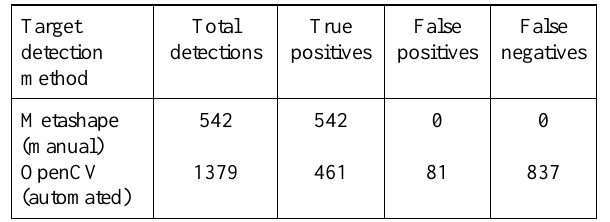
Table 2 . Output of the automated circular target detection OpenCV algorithm with comparison against Metashape output.